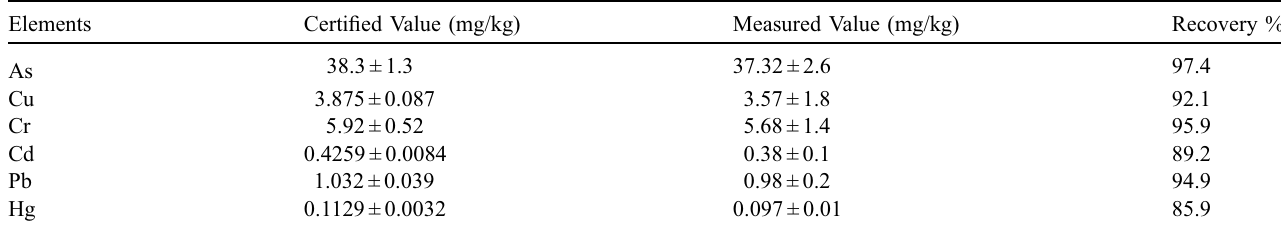
Table 1. Results of elemental levels in SRM of Thallus laminariae